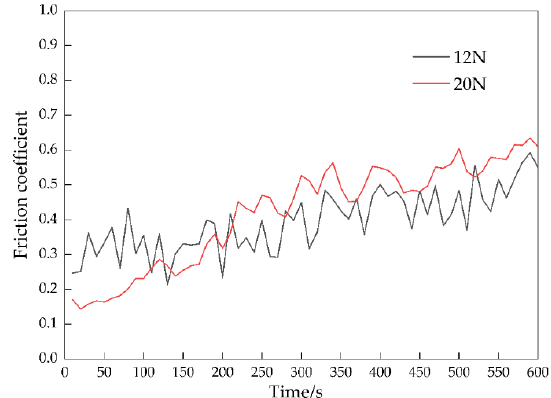
Figure 12. Friction coefficient curve.